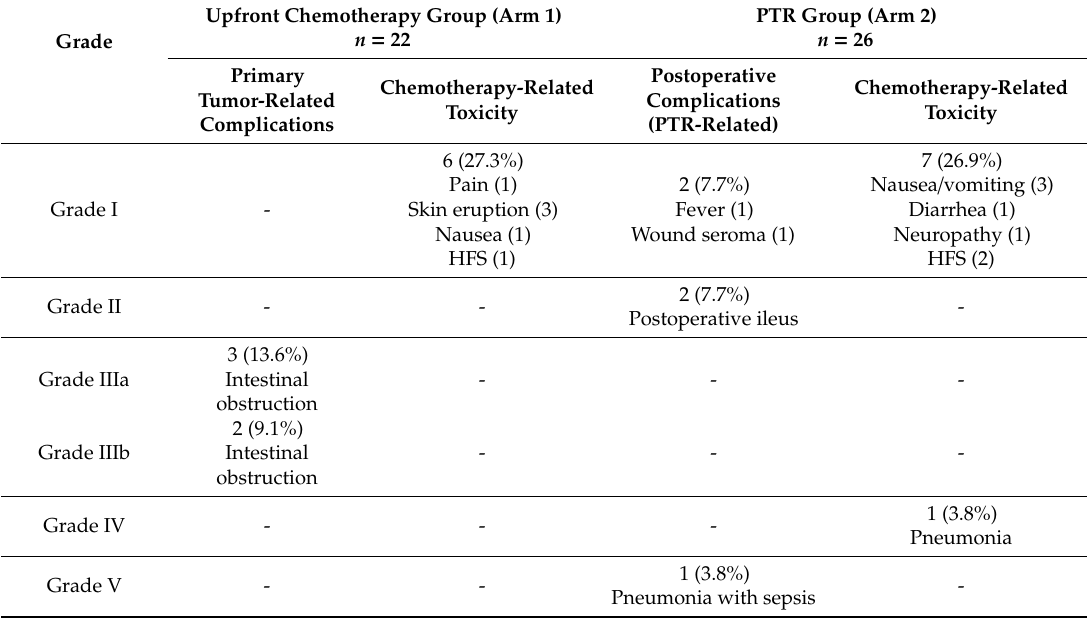
Table 4. Comparison of complications between the PTR and upfront chemotherapy